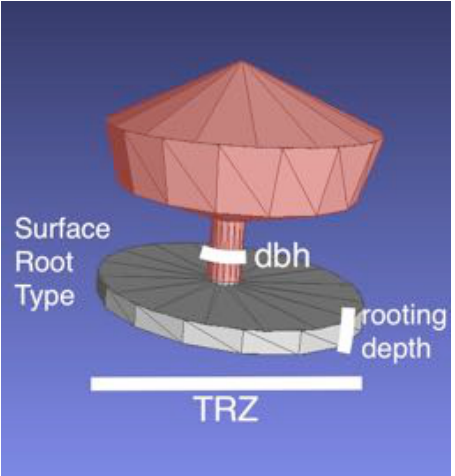
Figure 7. An example of a hypothetical tree species with a surface root type showing the parameters considered: Total Zone Radius or TZR, diameter at breast height and rooting